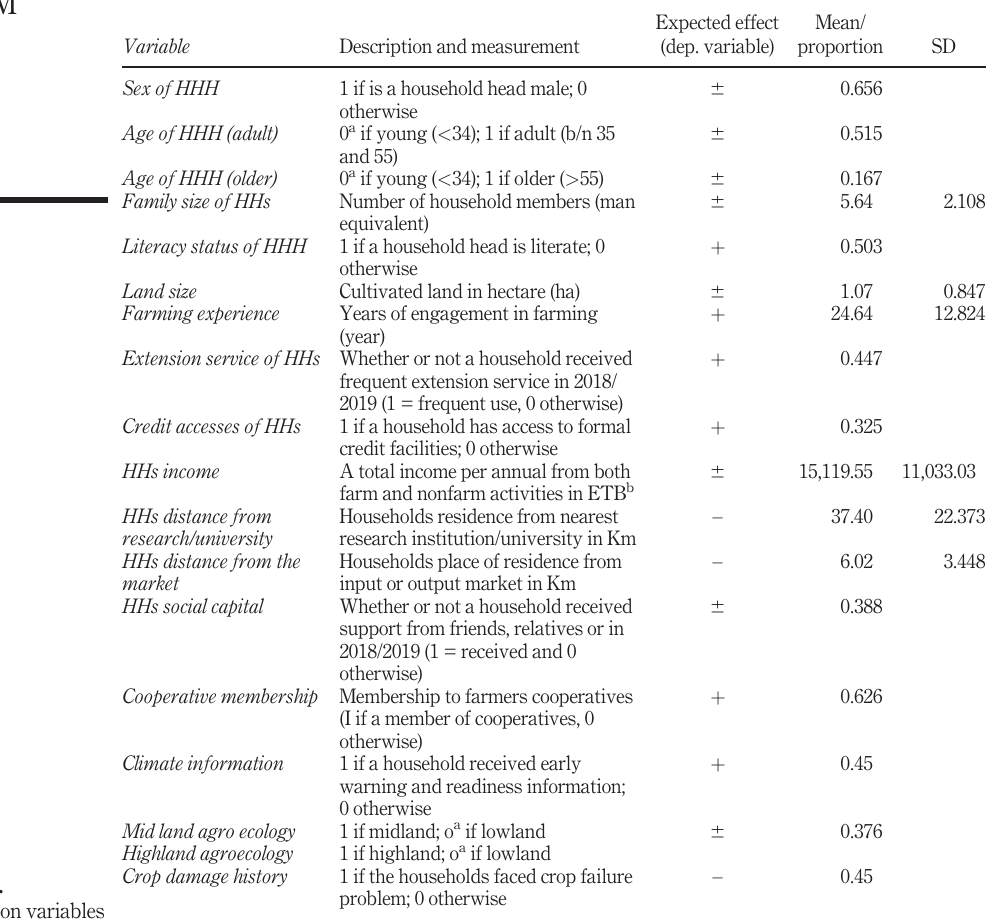
used in the analysis and sample